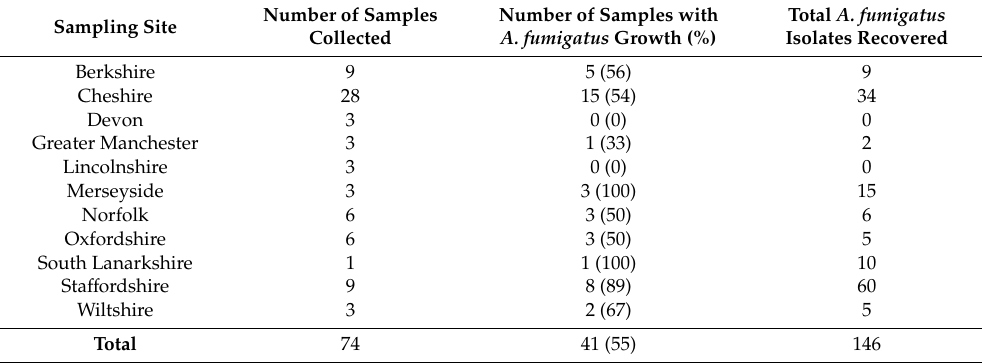
Table 1. Origin of soil samples on root vegetable transporters and A. fumigatus recovery rates.